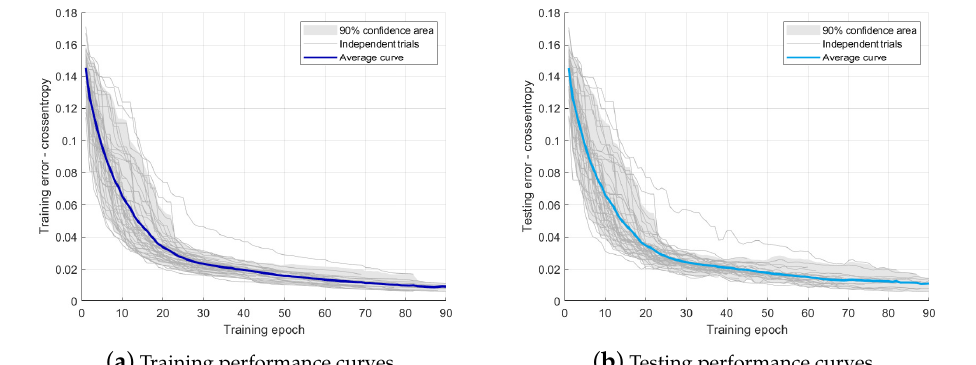
Figure 12. Training and testing convergence